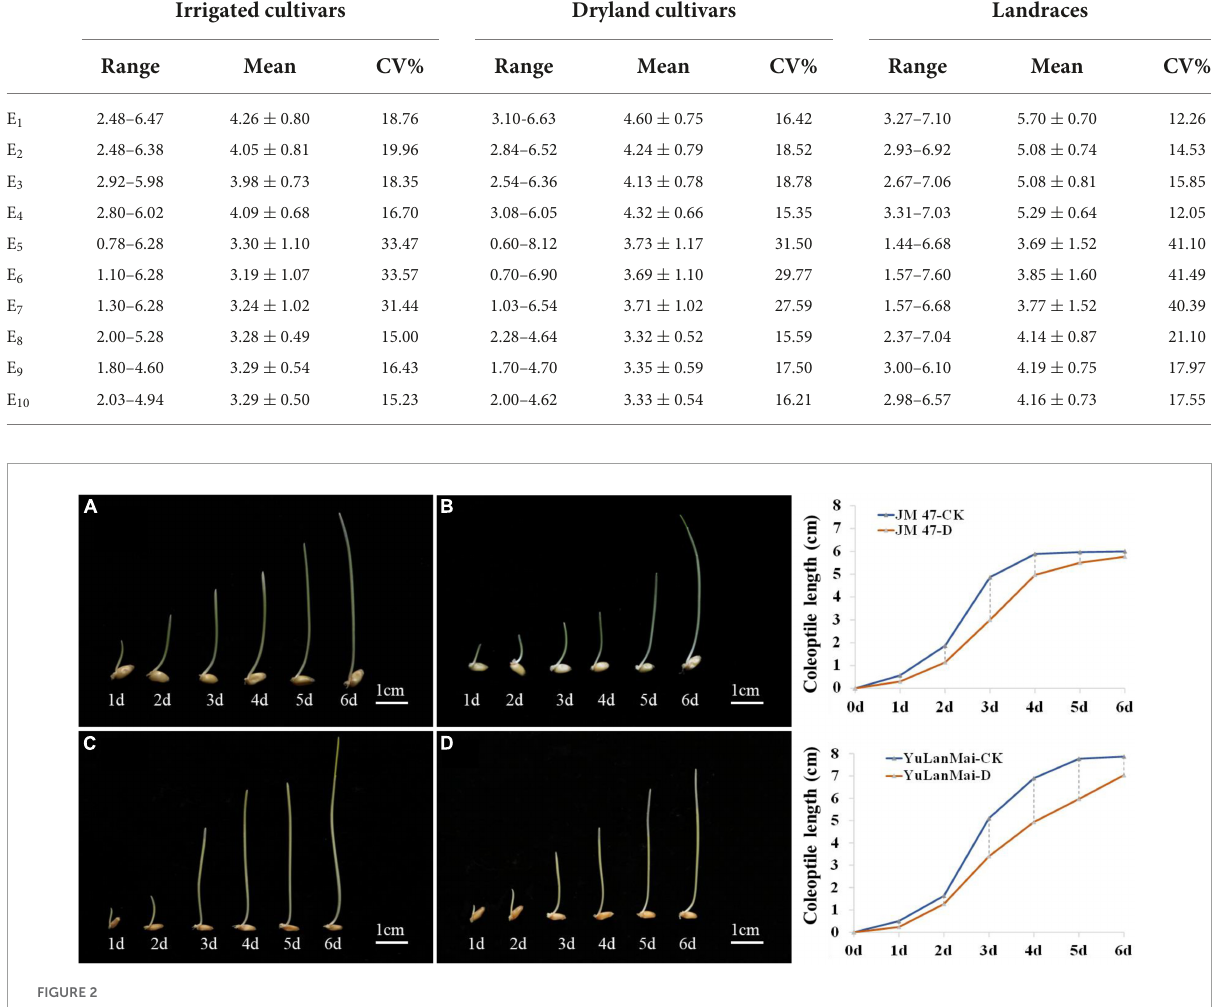
TABLE 1 Coleoptile length of irrigated cultivars, dryland cultivars, and landraces in various environments.